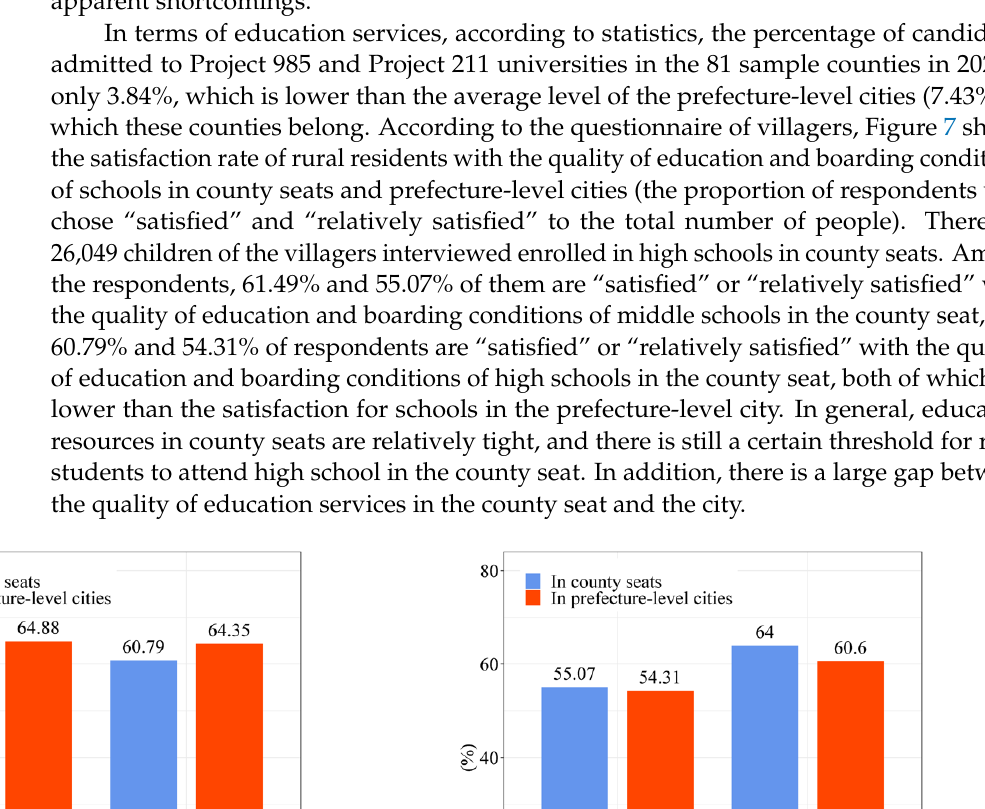
Figure 6. Rural residents’ choice of location for medical and health care (Source: by the authors).